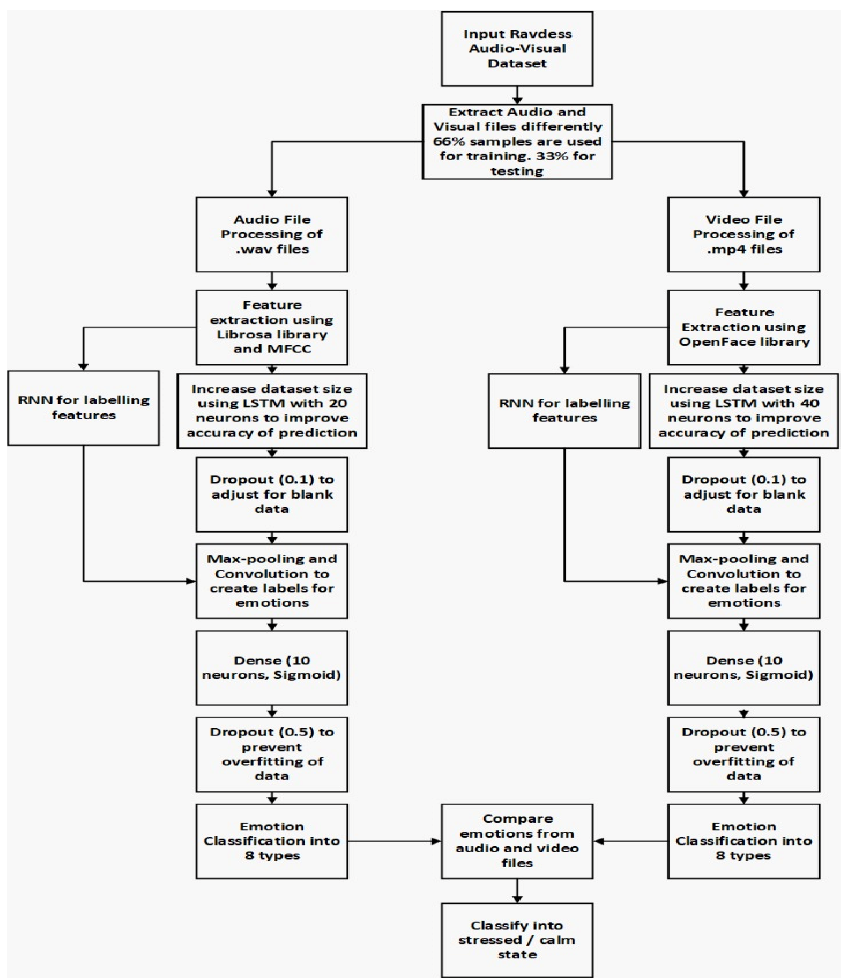
Figure 7. Proposed system workflow.